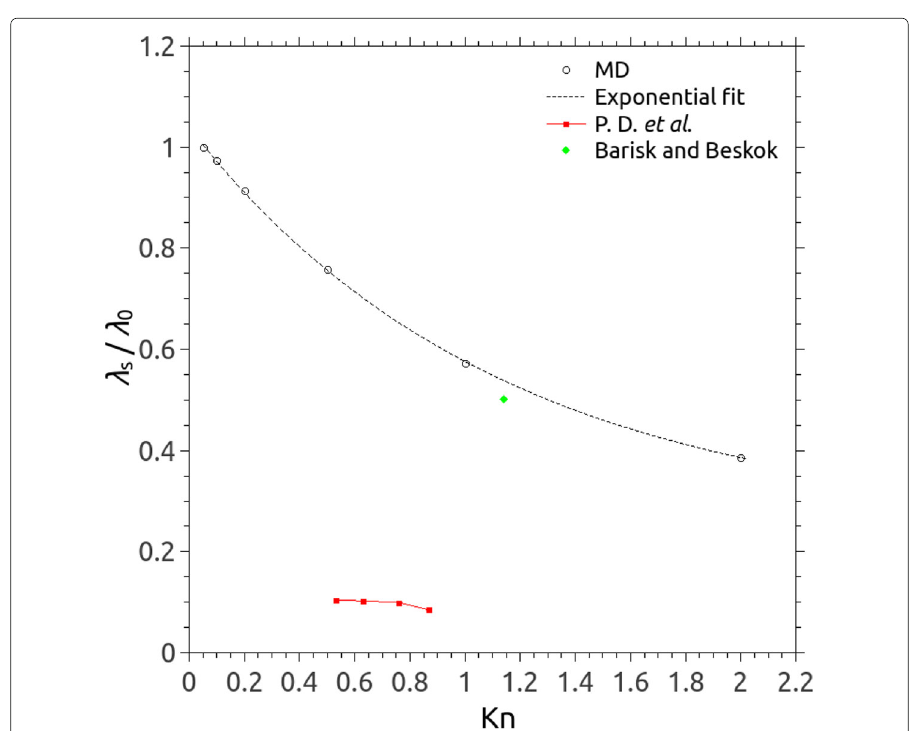
Fig. 4 The system MFP of a gas varies as the function of Kn using MD (open circles): λ s and λ 0 are the system MFP and the nominal MFP, respectively. An exponential fit can be expressed as λ s (Kn)/ λ 0 = 0.255 + 0.784 exp(-Kn/1.122) (the dotted line). The system MFPs in nanochanels obtained in MD simulations by Barisik and Beskok [28] (filled green diamond) and Perumanath Dharmapalan etal [29] (filled red squares) are also shown for comparison. Note that Kn was kept a constant by changing both the density of gas and channel height in [28], and the range of the channel height varied only from 6 nm to 16 nm in